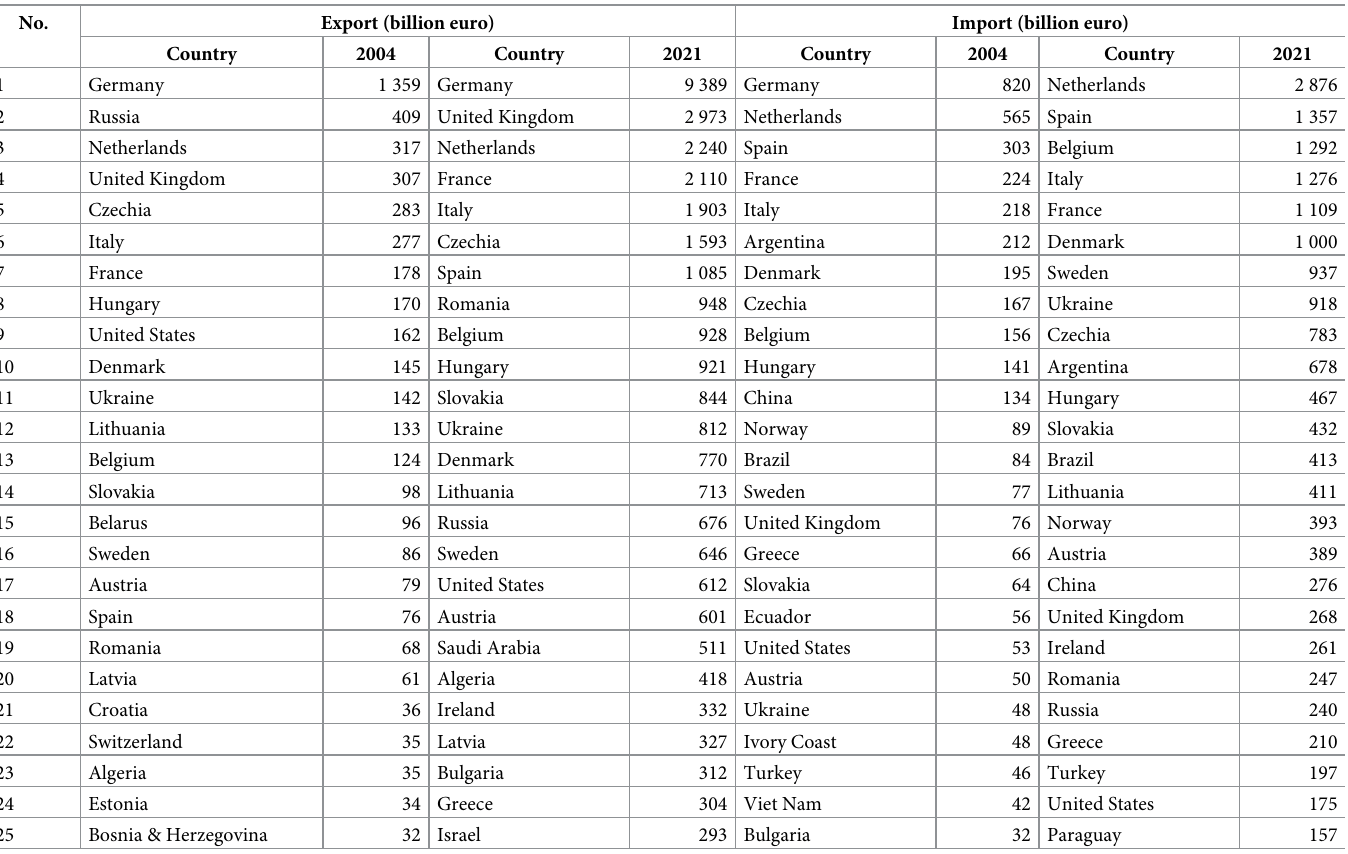
Table 3. Major trading partners in Poland’s agri-food trade in 2004 and